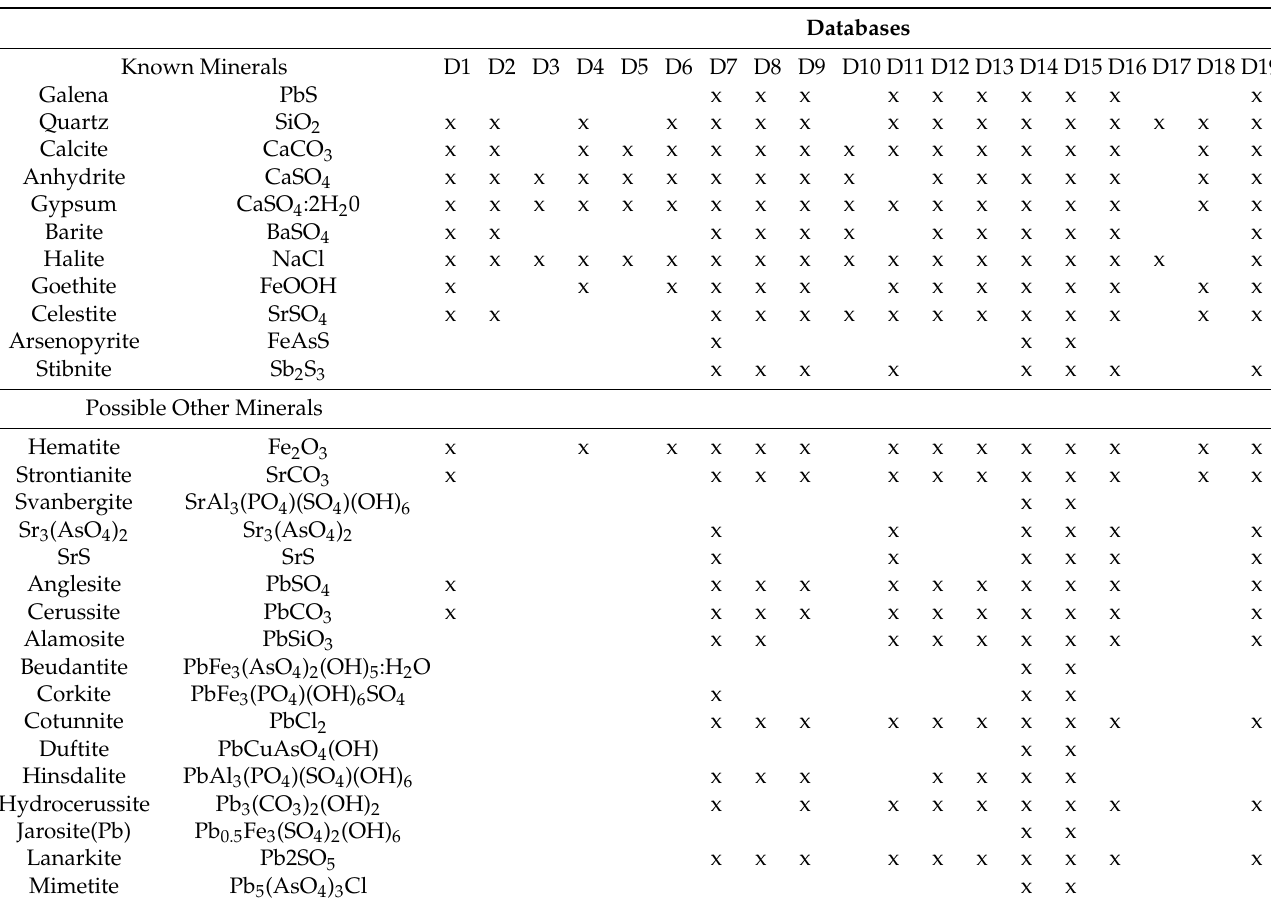
Table 6. Minerals in the